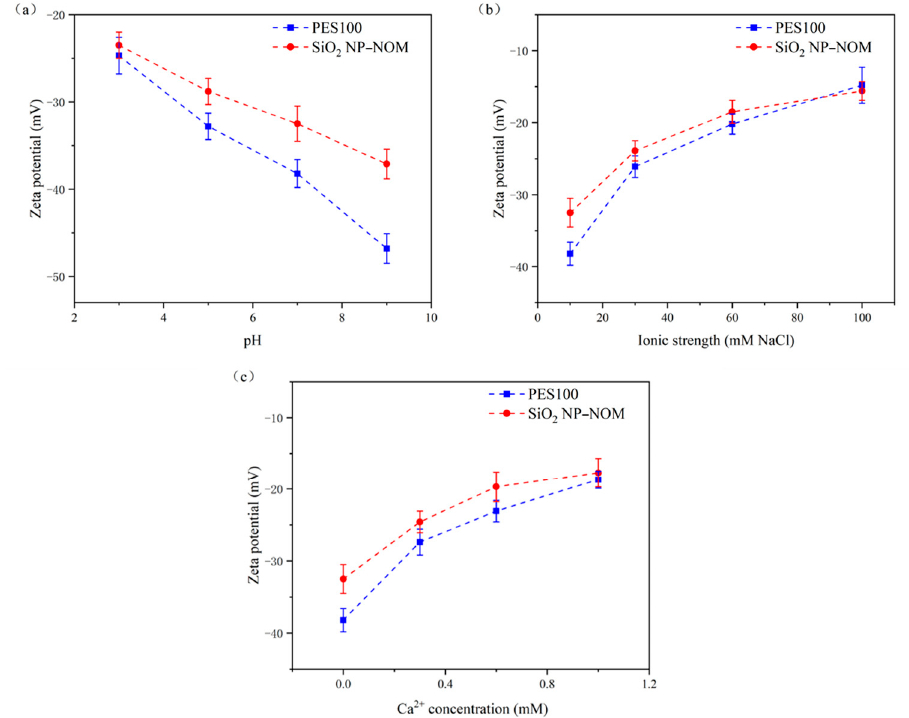
Figure 2. Variation of zeta potential of UF membrane and SiO 2 NP–NOM mixture as a function of solution chemistry: ( a ) pH, ( b ) ionic strength, and ( c ) calcium concentration.